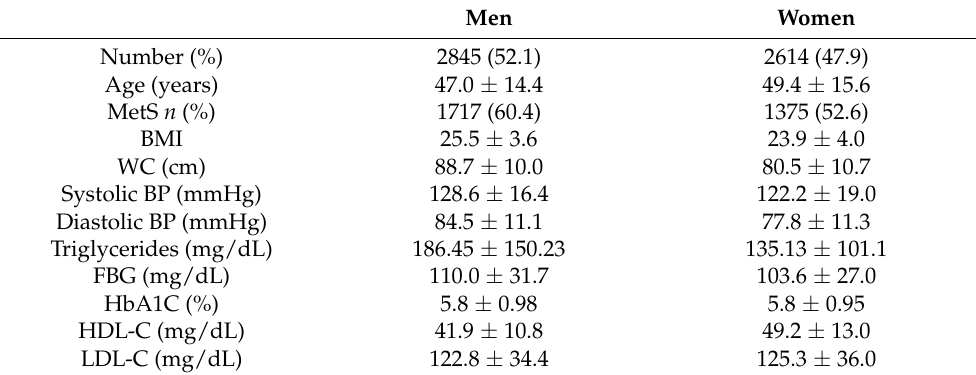
Table 1. Characteristics of participants by